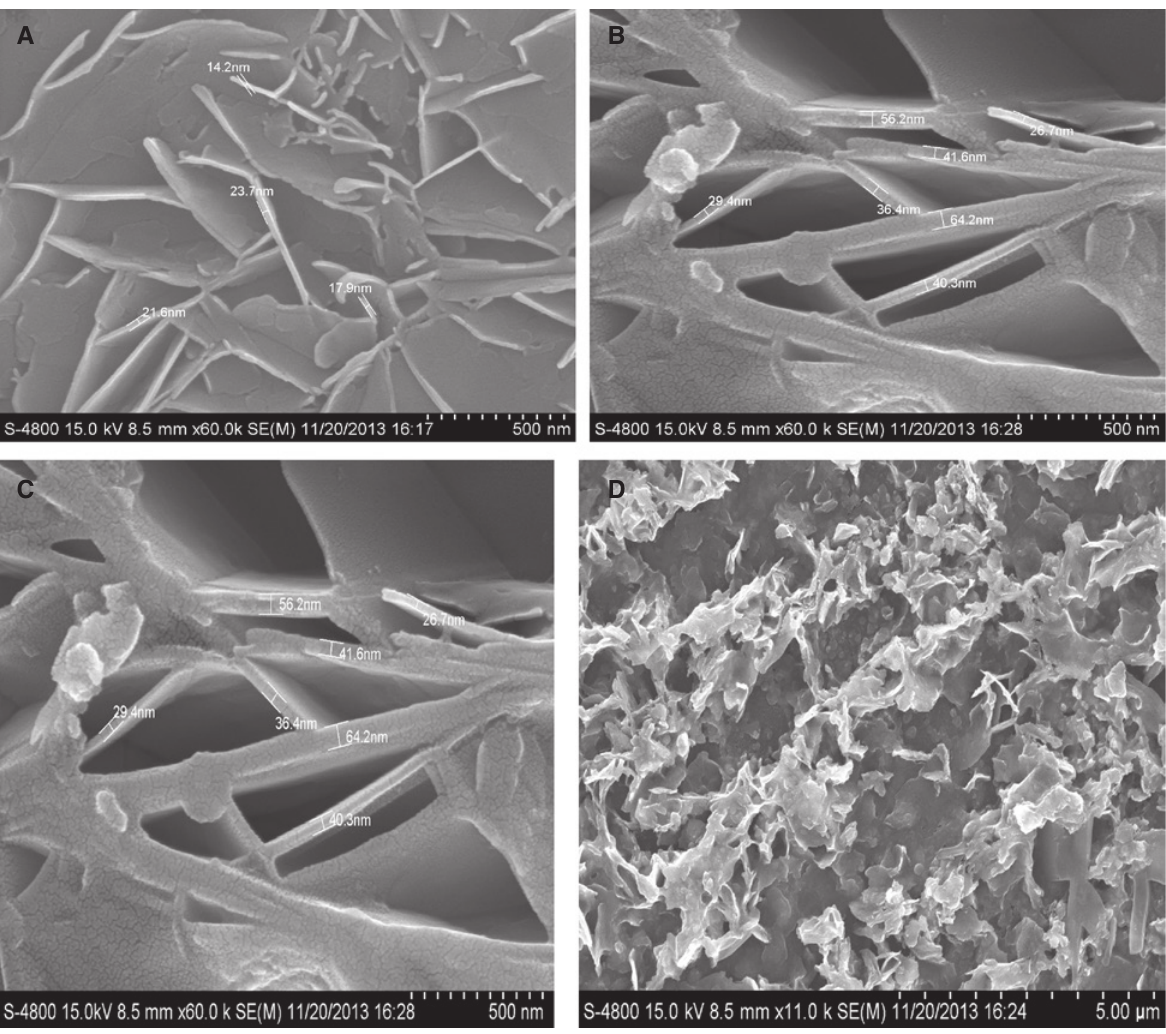
Figure 8: SEM images of the ZnO sample on ITO glass for power of atomization = 39 W. (A) flow rate = 1 ml/min, precursor concentra- tion = 0.05 m, (B) flow rate = 2 ml/min, precursor concentration = 0.05 m, (C) flow rate = 2 ml/min, precursor concentration = 0.05 m, and (D) flow rate = 2 ml/min, precursor concentration = 0.1